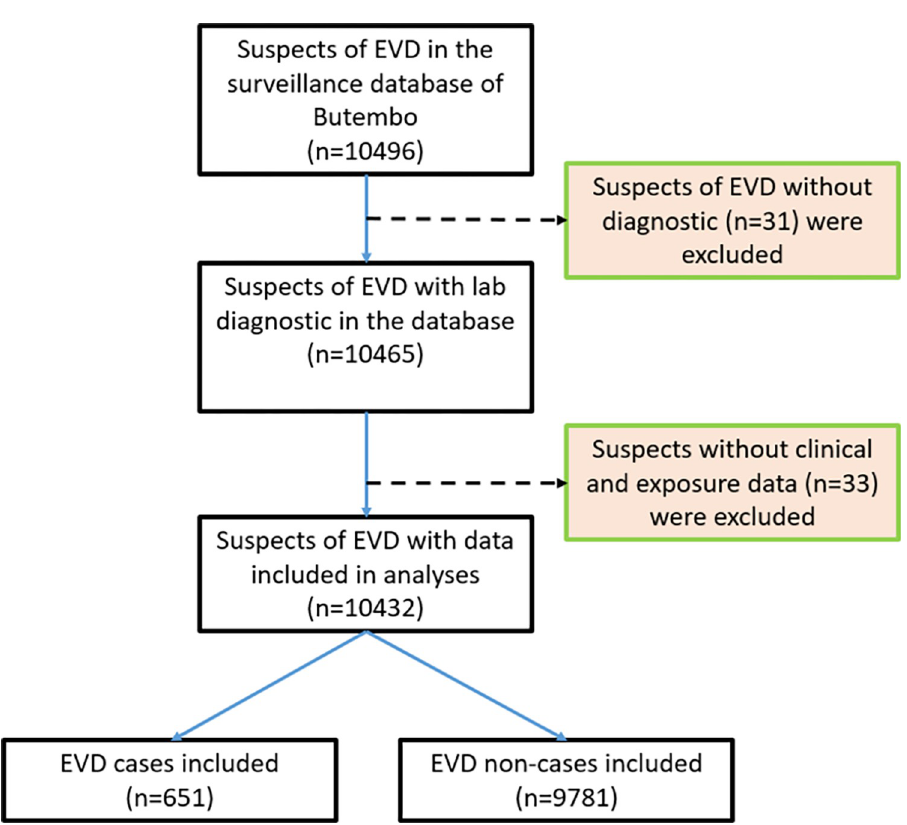
Fig 1. Flow diagram showing the number of EVD suspects included in the study and their outcomes. Classification of 10496 notified cases according to the WHO guideline case Definition for Ebola virus disease (EVD) during the Ebola virus Outbreak in BUTEMBO,